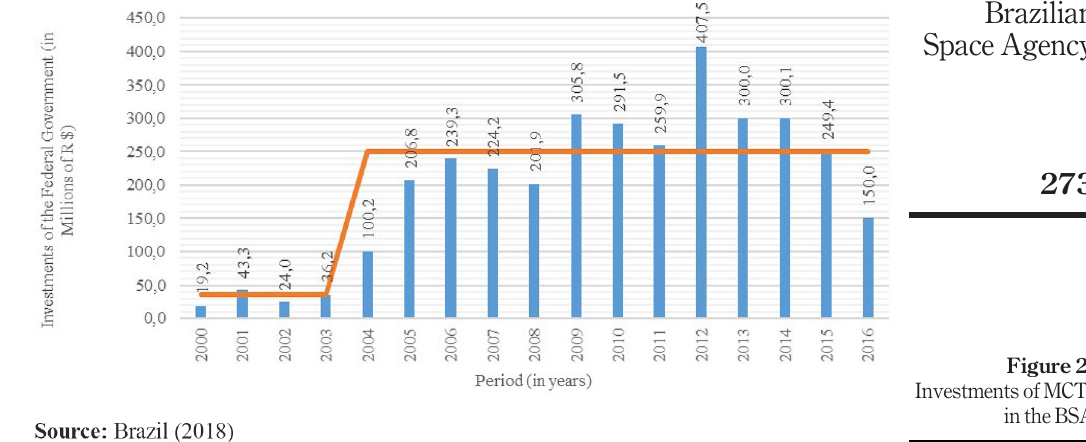
Figure 2. Investments of MCTI in the